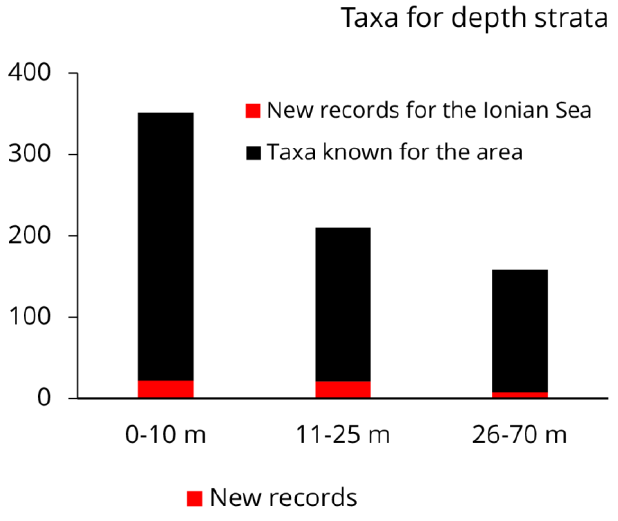
Figure 7. Total number of taxa and new records (in red) found by this study per depth strata .